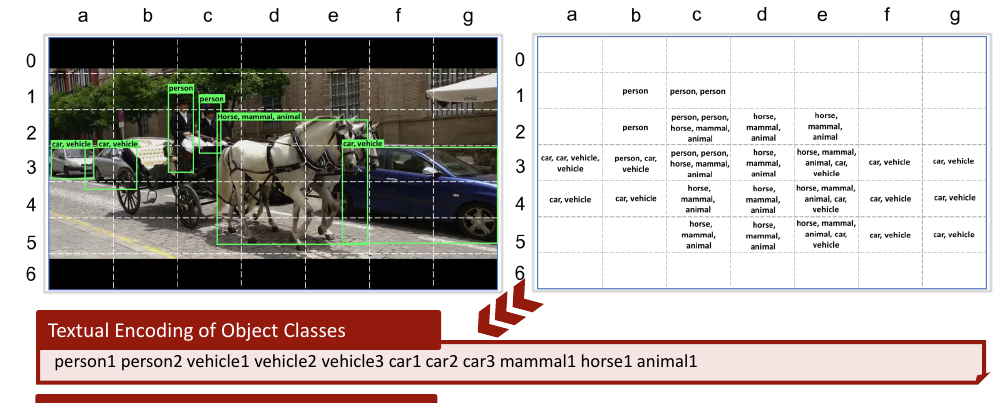
Figure 7. Example of our textual encoding for objects and their spatial locations (second box): the information that the cell a3 contains two cars is encoded as the concatenation a3car a3car . In addition to the position we encode also the number of occurrences of the object in the image (first box): the two person are encoded as person1 person2